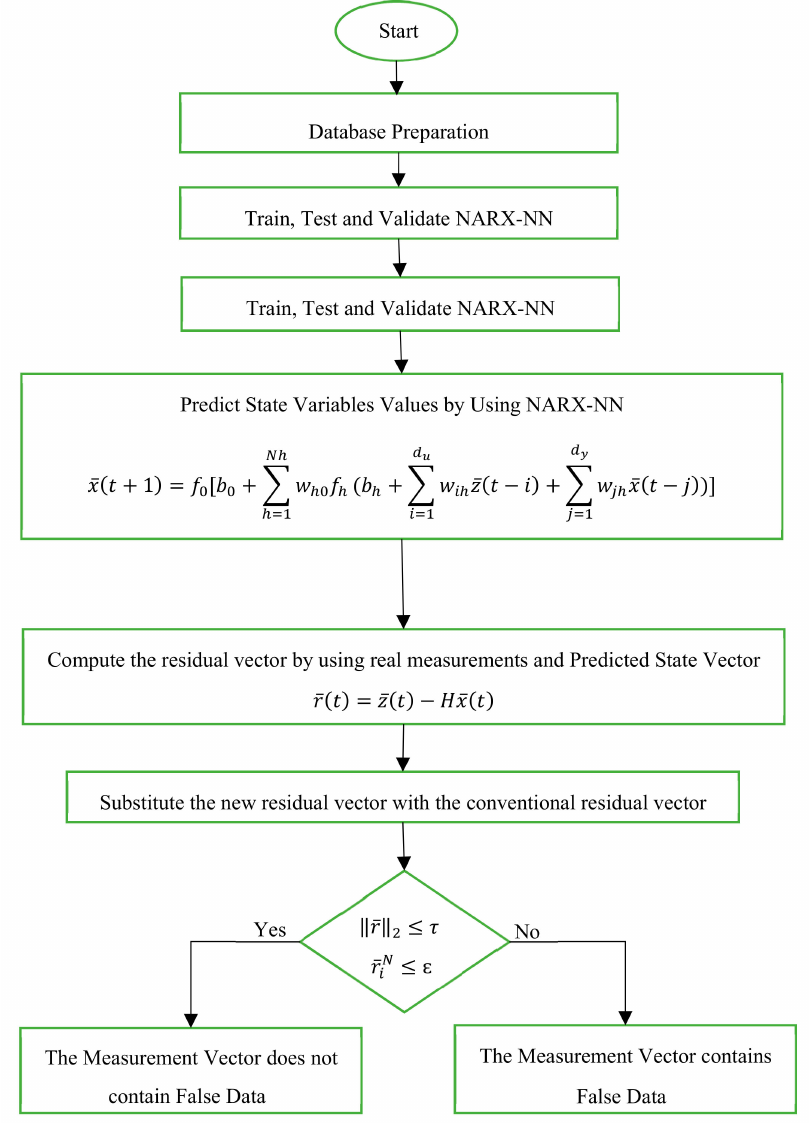
Figure 3. RNARXNN-based BDD